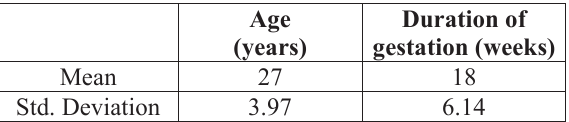
Table-1: Age & duration of gestation at presentation in